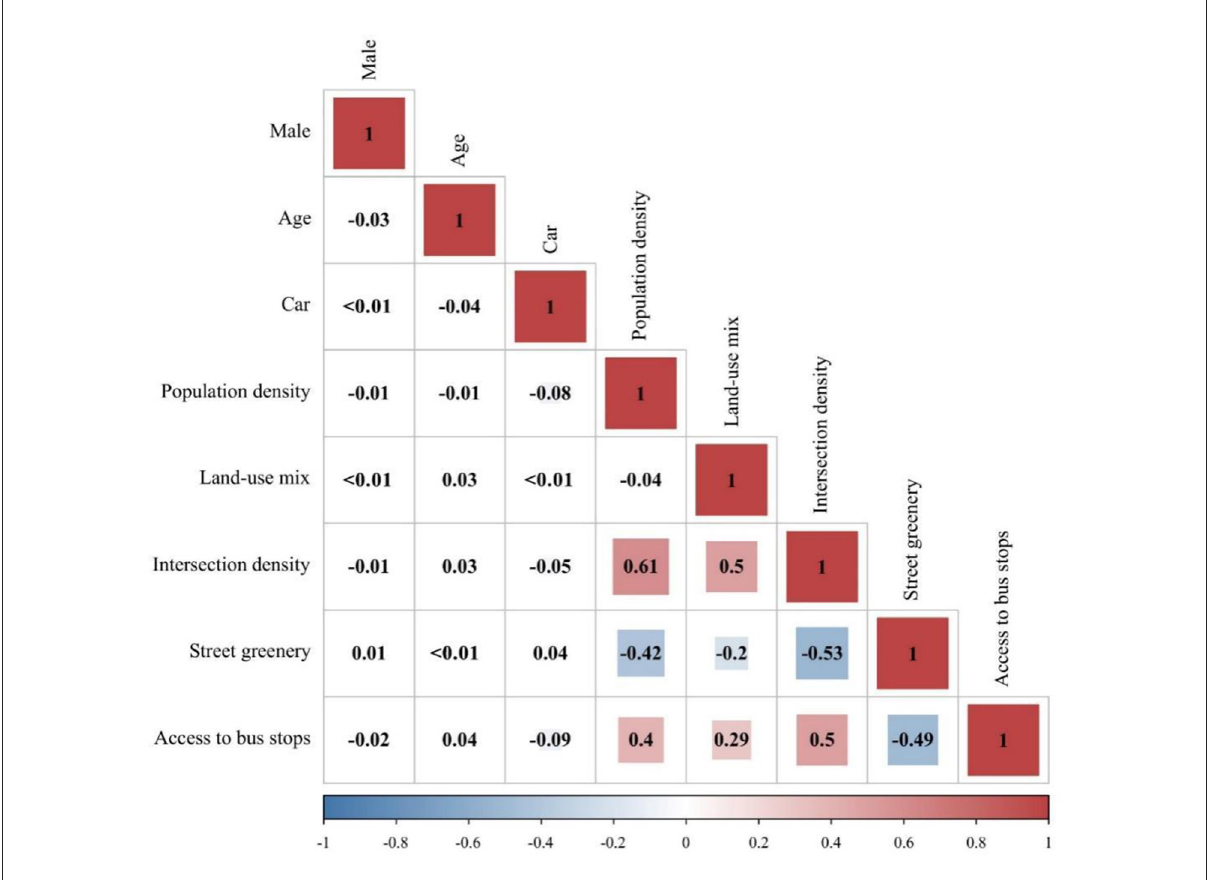
FIGURE5 Correlation coefficients among the